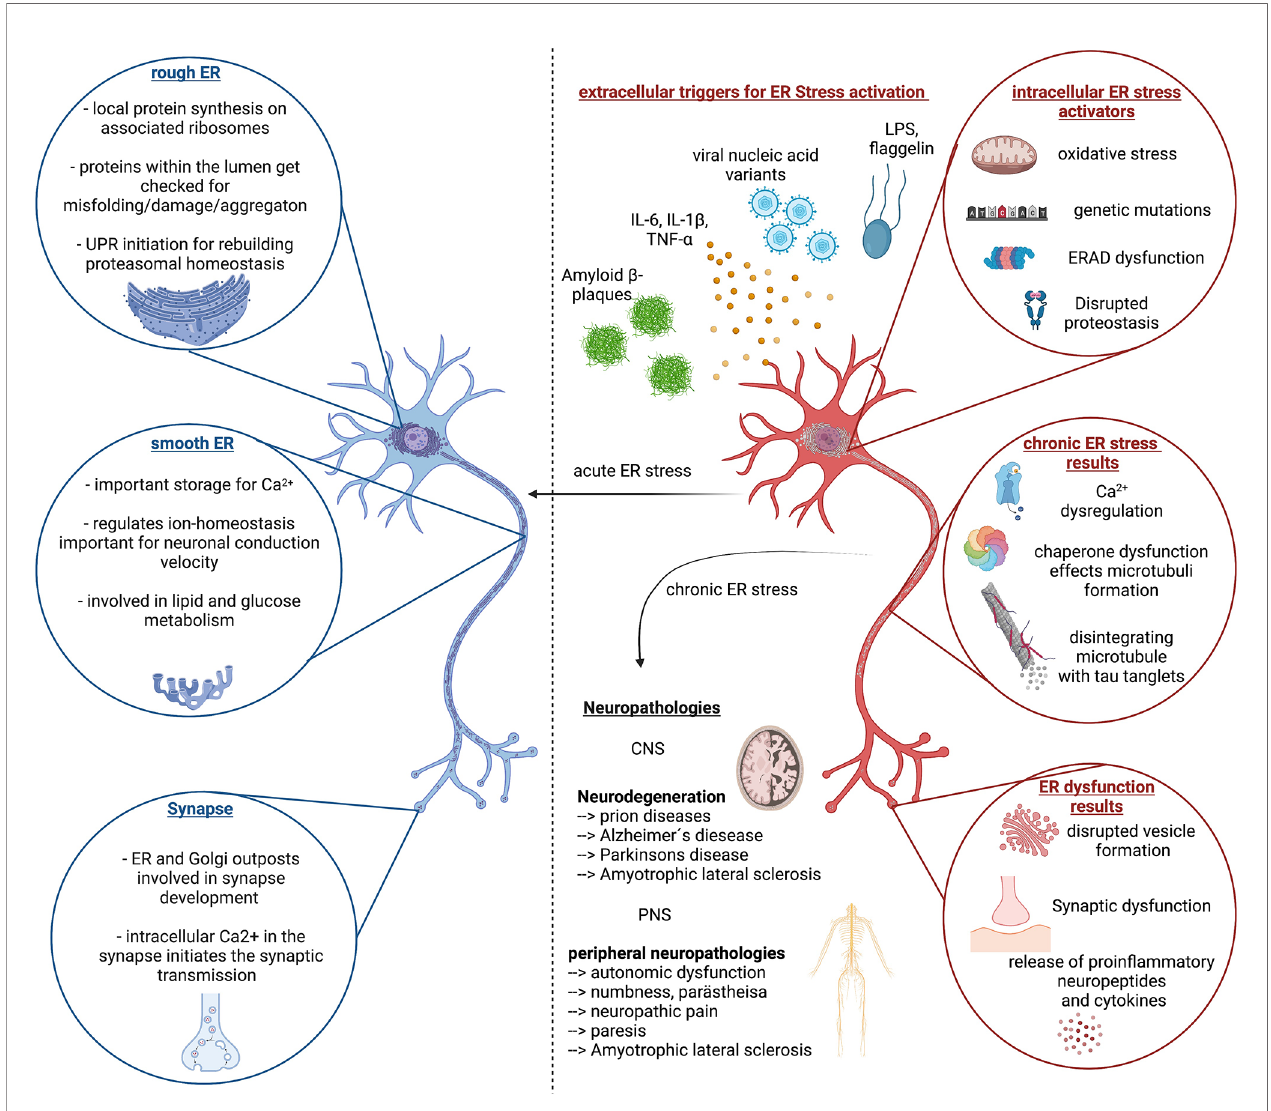
FIGURE 2 | ER stress response in homeostasis and disease. Left (blue color) side depicts important function of the Endoplasmic reticulum (ER) in neuronal cells and highlights the importance of proper ER function for neuronal function, which is reinstated by the unfolded protein response (UPR) and proper regulation of proteasomal degradation and synthesis. The right side (red color) depicts the extra- and intracellular stressors that can lead to chronic ER stress, associated with continues disruption of neuronal cell homeostasis followed by dysfunction and decline. This circulus vicious is a foundation of multiple neurological diseases of the CNS and PNS of which the most common ones are listed here. Created with